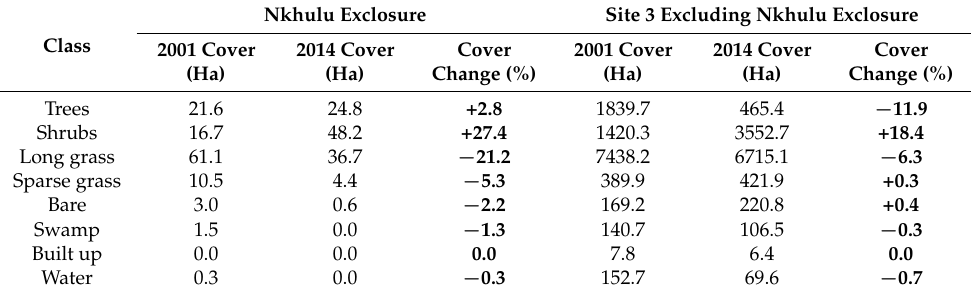
Table 5. Land cover change between 2001 and 2014 within and outside the Nkhulu exclosure area. Cover change % corresponds to the percentage of the full exclosure area, or site 3 image footprint excluding the exclosure area